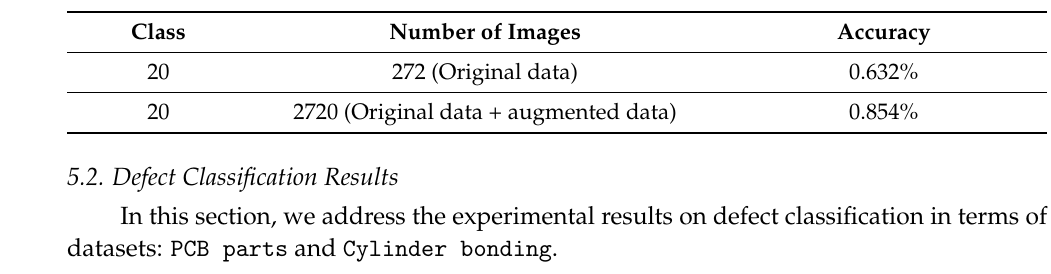
Table 5. Performance enhancement by using data